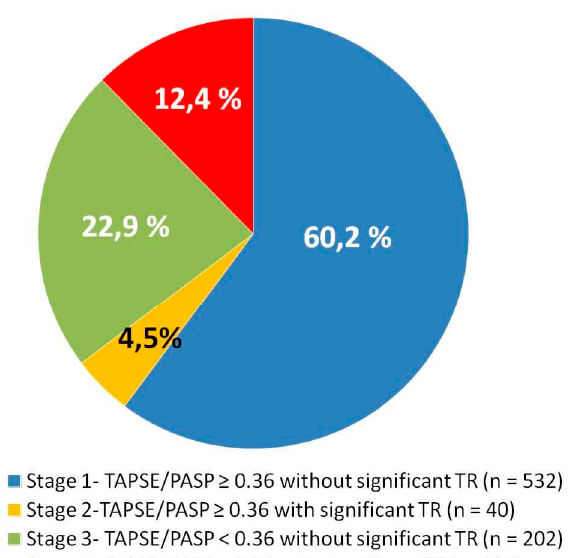
Figure 2. Distribution of right ventricular dysfunction stages in the total study population. TAPSE/PASP: tricuspid annular plane systolic excursion to pulmonary artery systolic pressure ratio; TR: tricuspid regurgitation.